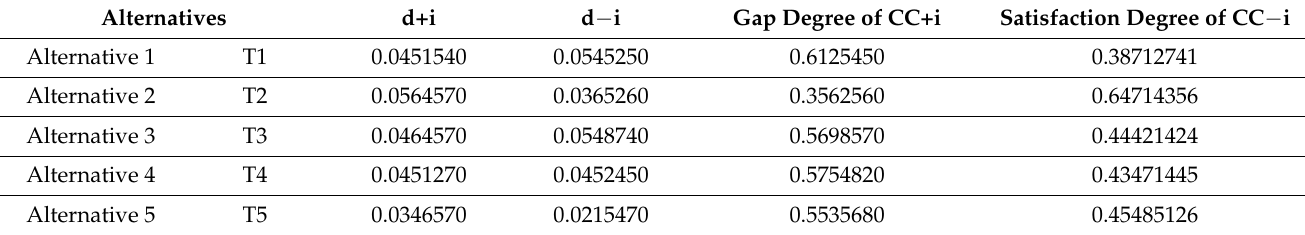
Table 15. The closeness coefficients for the aspired level among the different